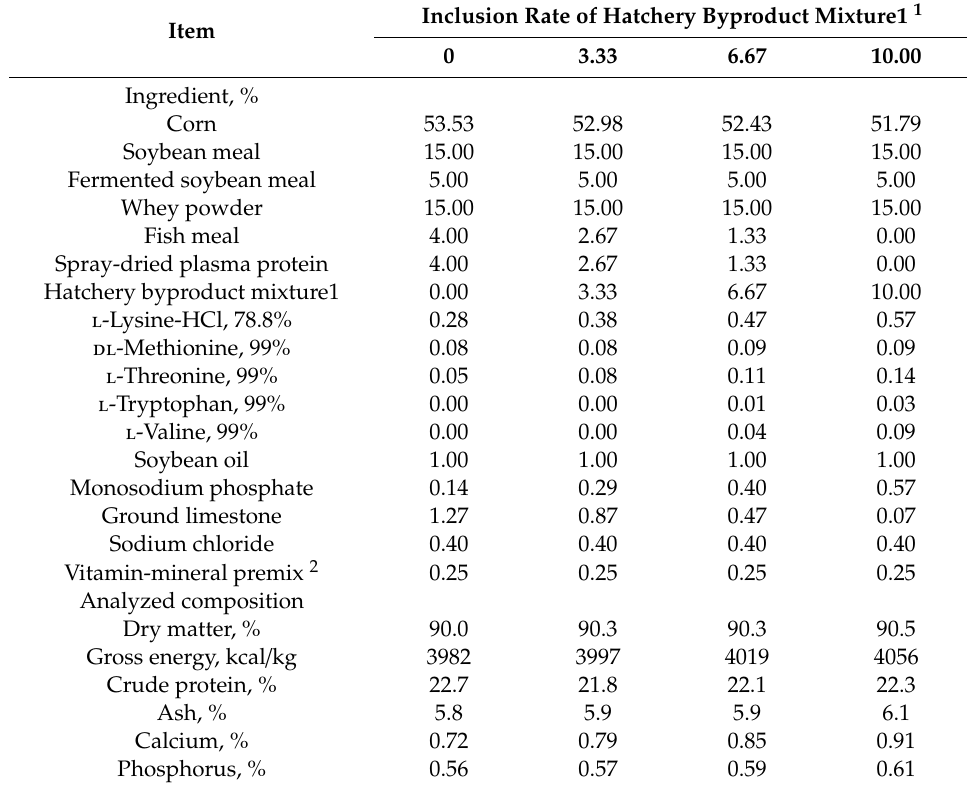
Table 2. Ingredients and chemical compositions of the experimental diets, as-fed basis (growth performance experiment). Inclusion Rate of Hatchery Byproduct Mixture1 Item